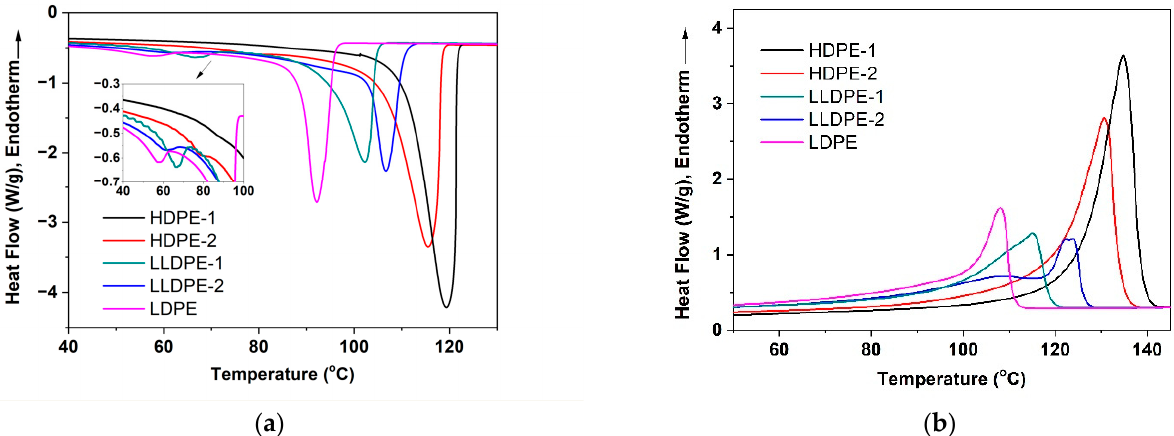
Figure 1. DSC cooling (10 °C/min) curves ( a ) and subsequent heating curves ( b ) of different PEs studied in this work. Table 2. Characterization of the neat PEs during DSC cooling and subsequent heating at a given rate of 10 °C /min.